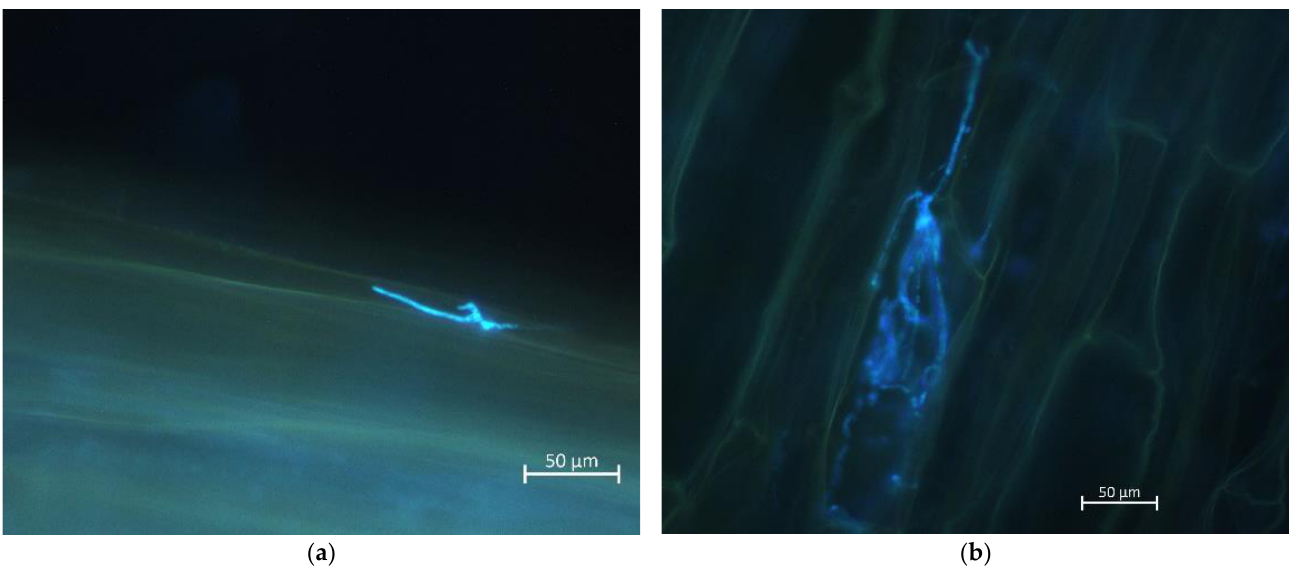
Figure 5. Fungal structures (Foxy III) in the susceptible genotype A. officinalis cv. Thielim 72 hpi. Fungal cell walls stained using Calcofluor White M2R. ( a ) Growing hypha; ( b ) Mycelium spreading from a cell.